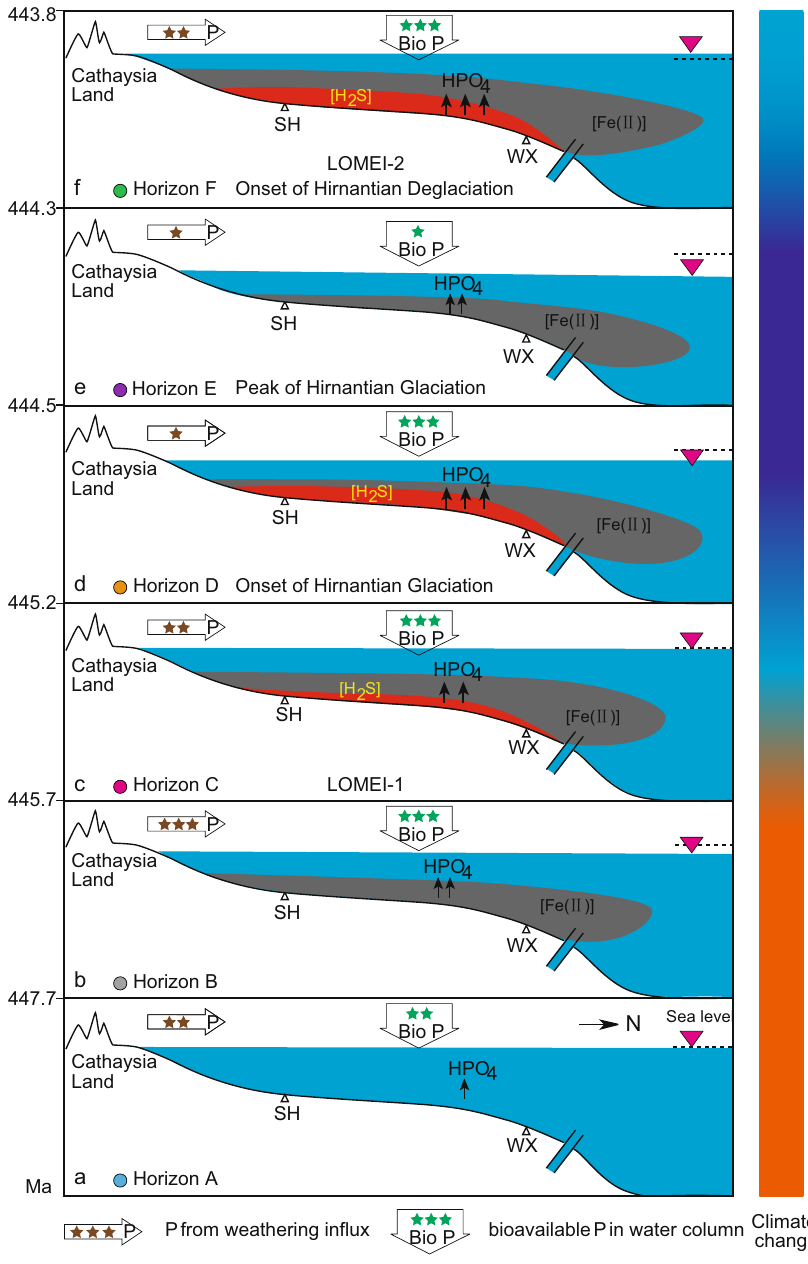
Fig. 3 Conceptual model for the high-resolution redox development and P recycling on Yangtze Shelf Sea in South China. a Horizon A; b Horizon B; c Horizon C; d Horizon D; e Horizon E; f Horizon F. Two progressive expansions of euxinia led to intense increases in P recycling, which peaked in Horizons C – D and F, and these correspond to the two extinction intervals (LOMEI-1 and